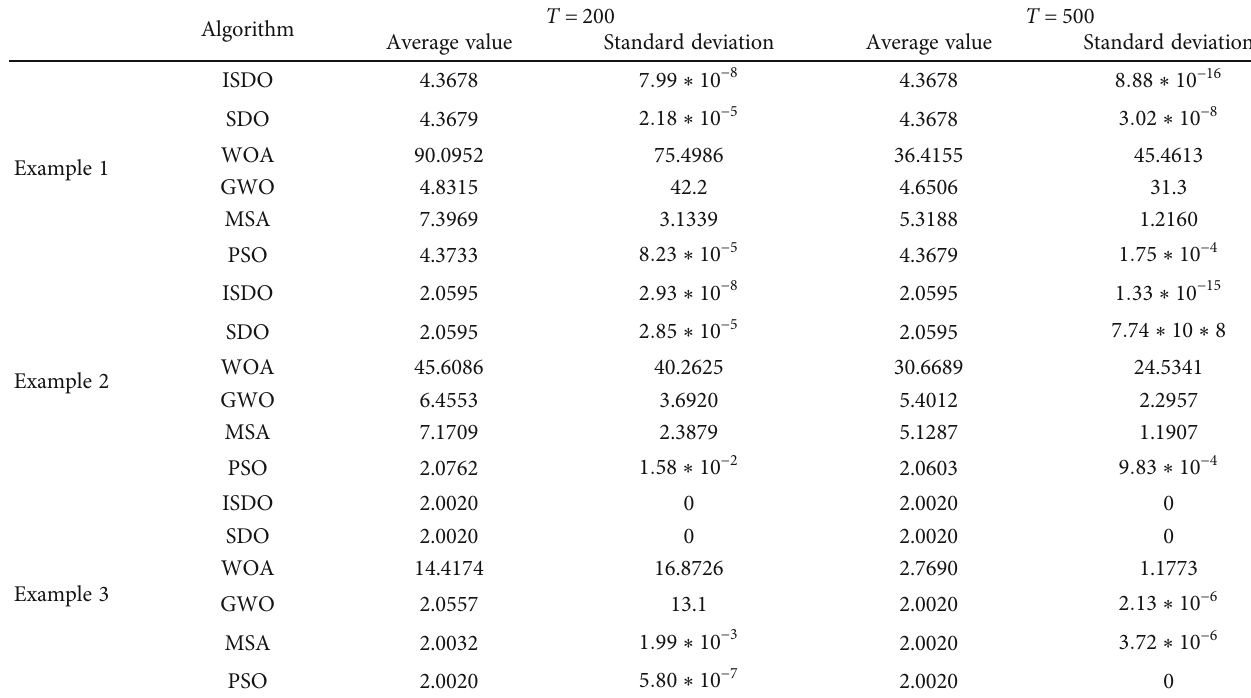
Table 2: Comparison results of objective function optimization of application